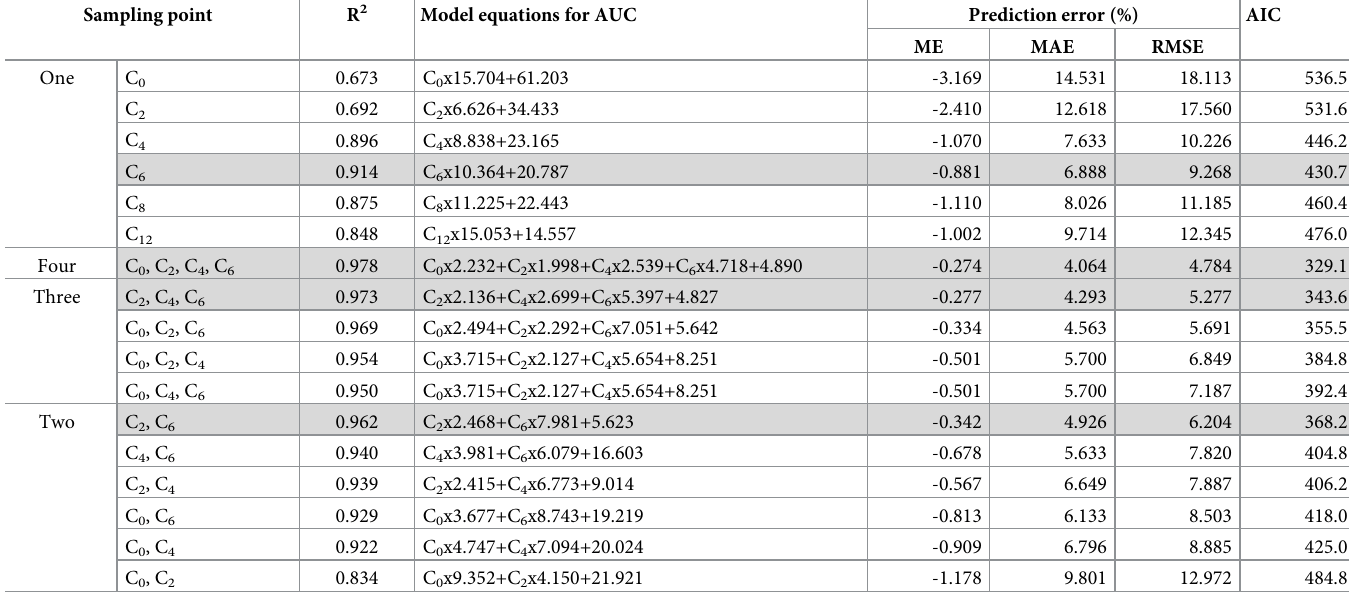
Table 2. Predictive performances of the limited sampling equations for AUC with various sampling time points. Sampling